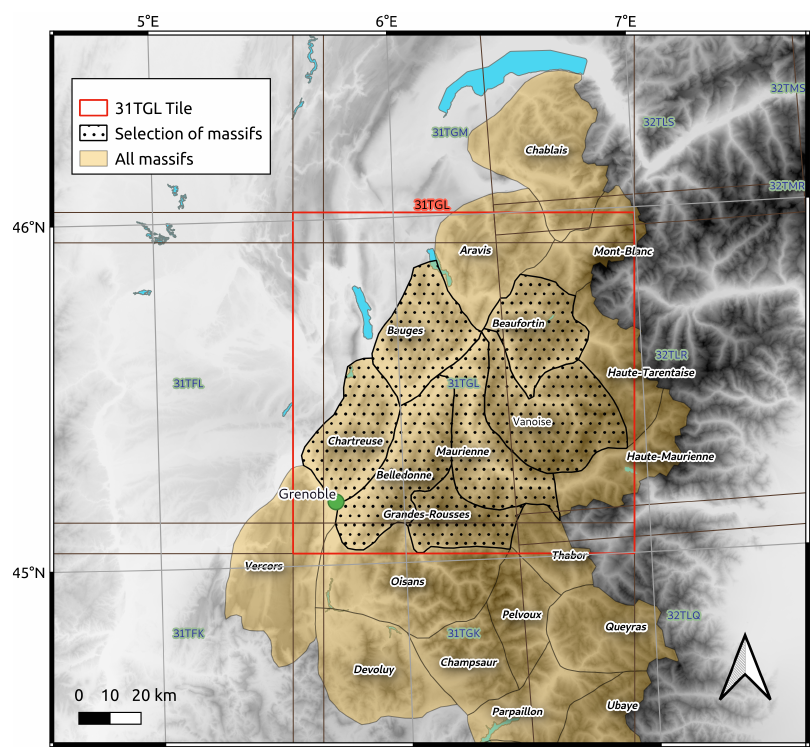
Figure 1. Location of the study